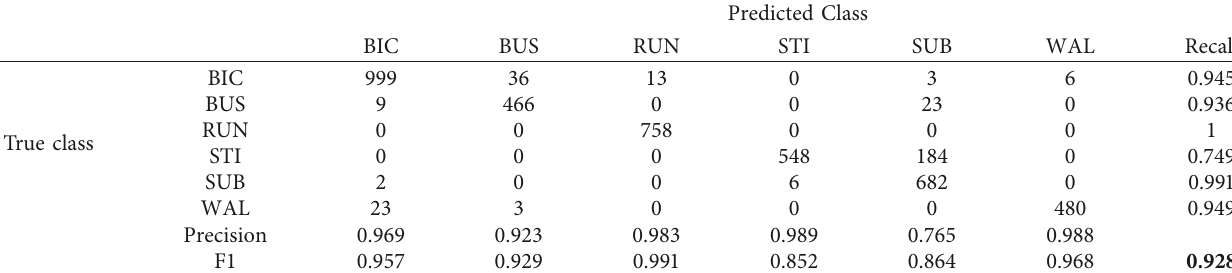
Table 4: Results of confusion